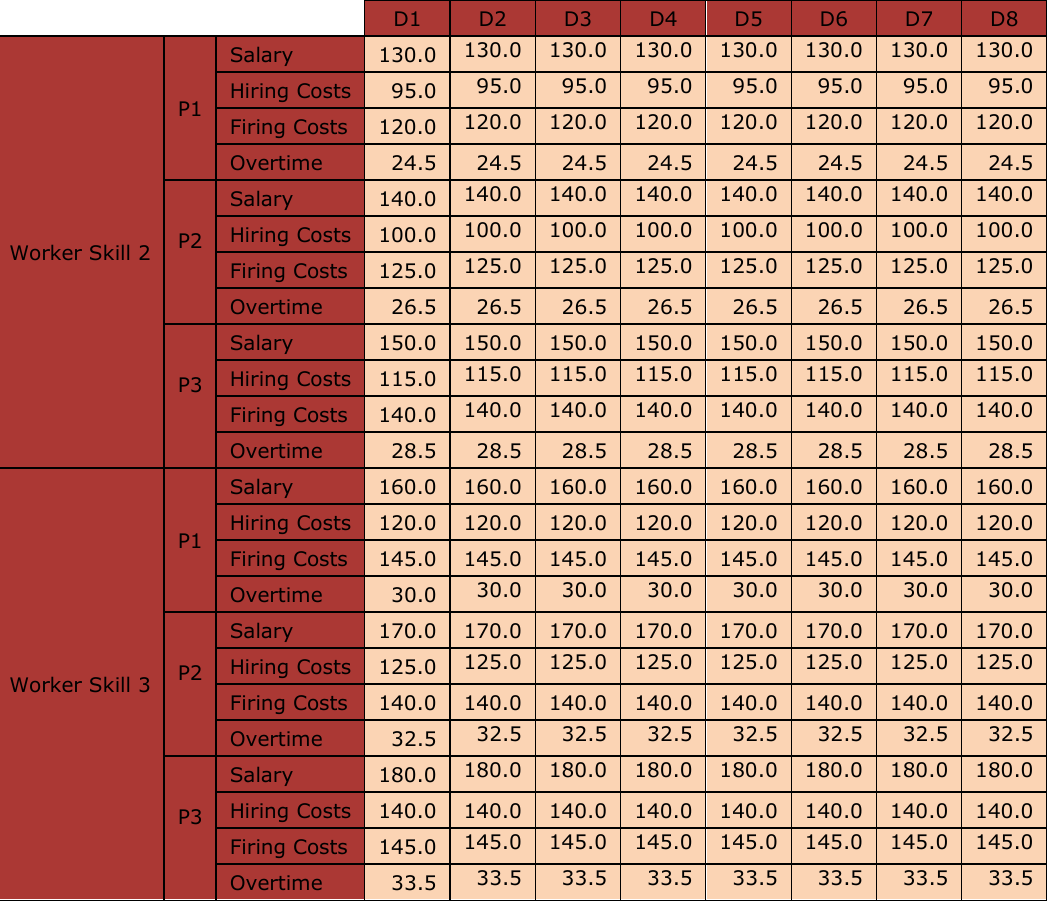
Table 6. Salary, Hiring, Firing, and Hourly Overtime Costs ($)